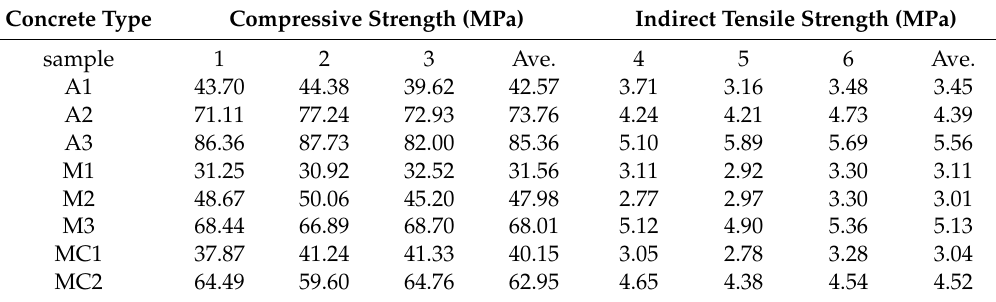
Table 2. Compressive and indirect tensile strength for concrete types A, M and MC after 28 days.